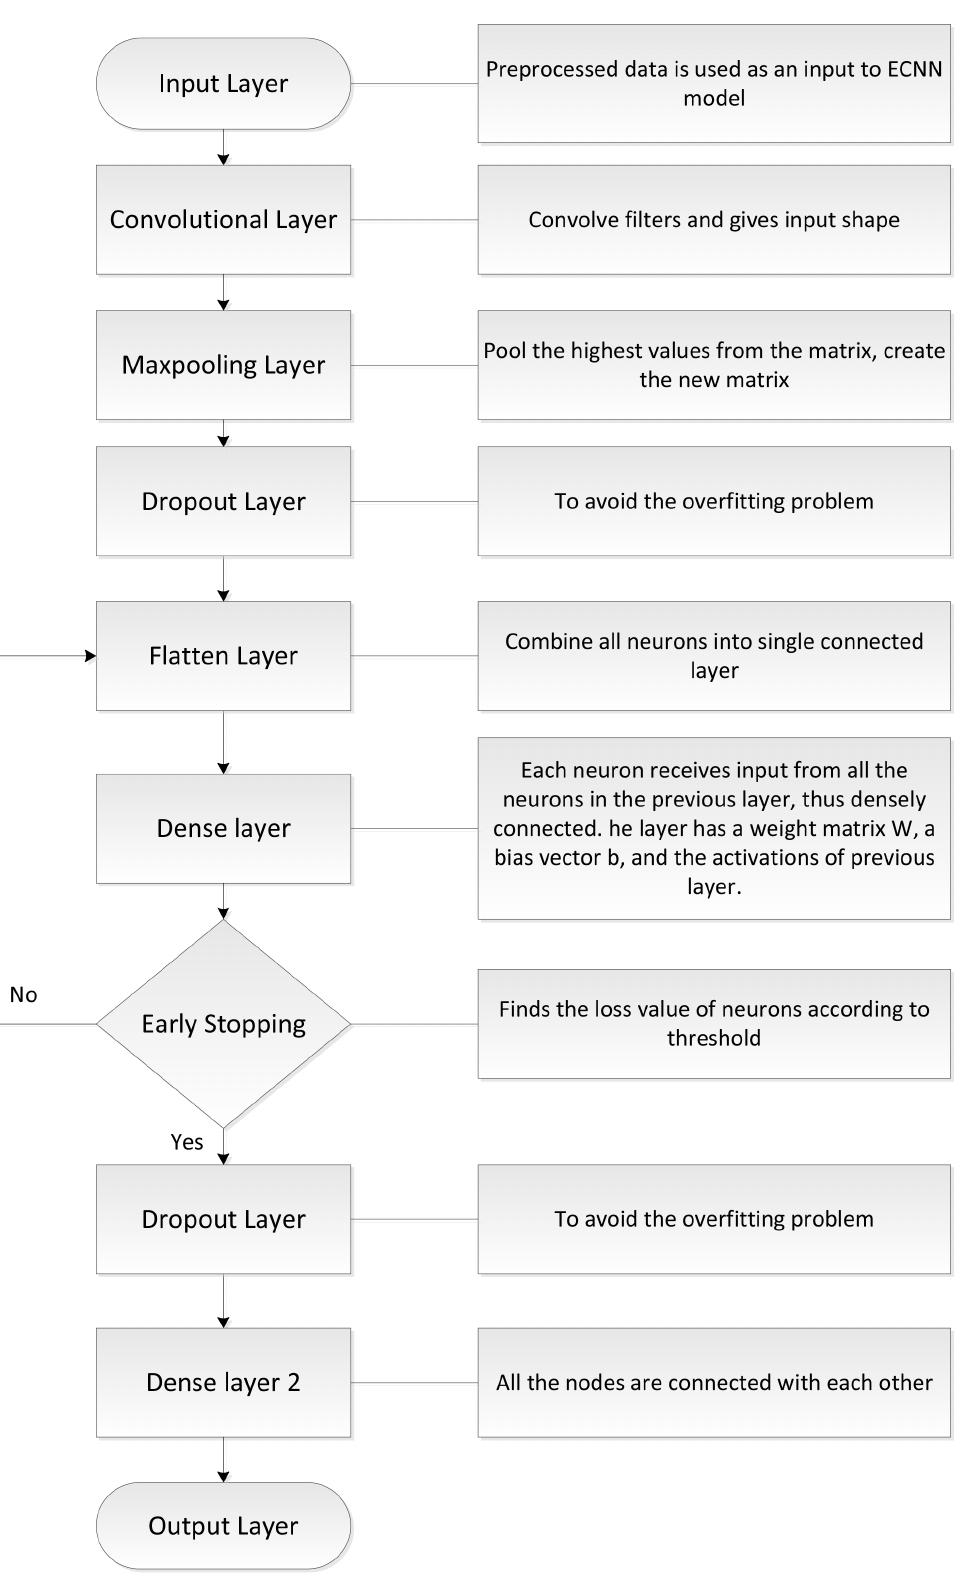
Figure 4. Enhanced Convolutional Neural